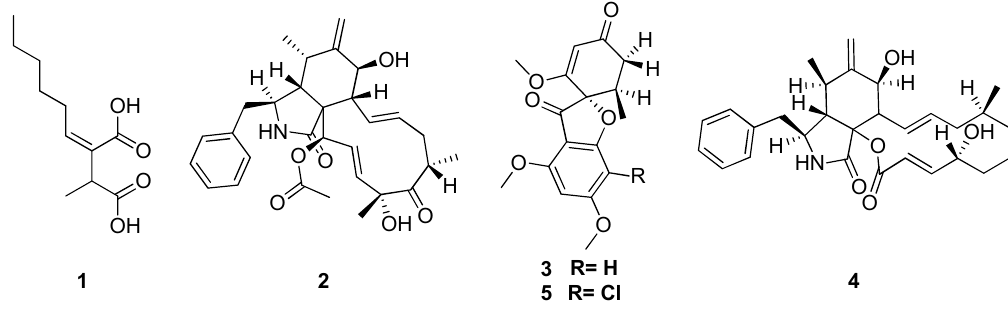
Figure 3. Five compounds extracted from Xylaria sp.